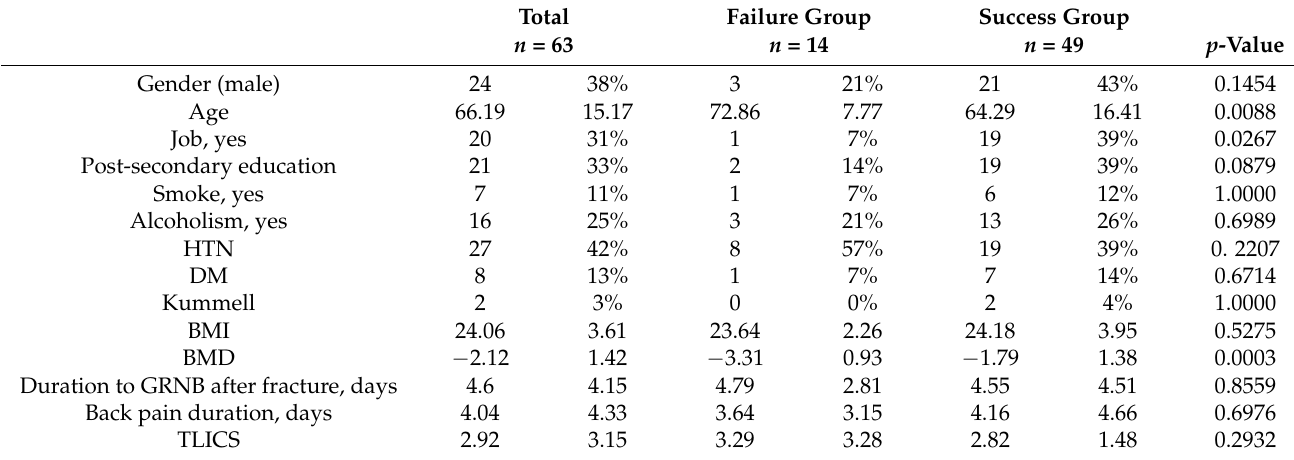
Table 1. Demographic and clinical characteristics of the study patients (number =